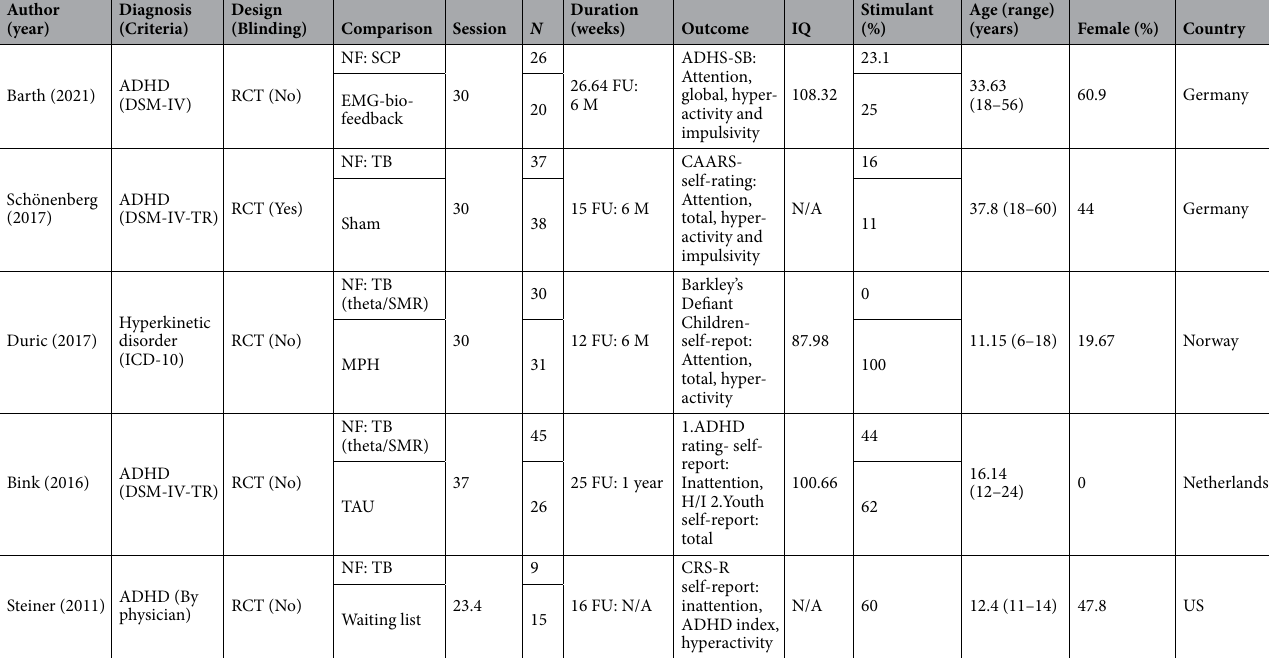
EEG-NF and comparison groups (Fig. 6). Sensitivity analysis indicated stability of the merged results of out- comes when removing one study at a time. Dropout rate. Forest plots of the five studies with a total of 330 patients (NF group, n = 183 vs. comparison group, n = 147) available for the analysis of dropout rate showed no significant difference between EEG-NF and comparison groups (RR = 1.05, 95% CI 0.82 to 1.33, p = 0.72; I 2 = 0%) (Fig. 7). Besides, Sensitivity analysis dem- onstrated no significant effect on this outcome by omitting certain trials.